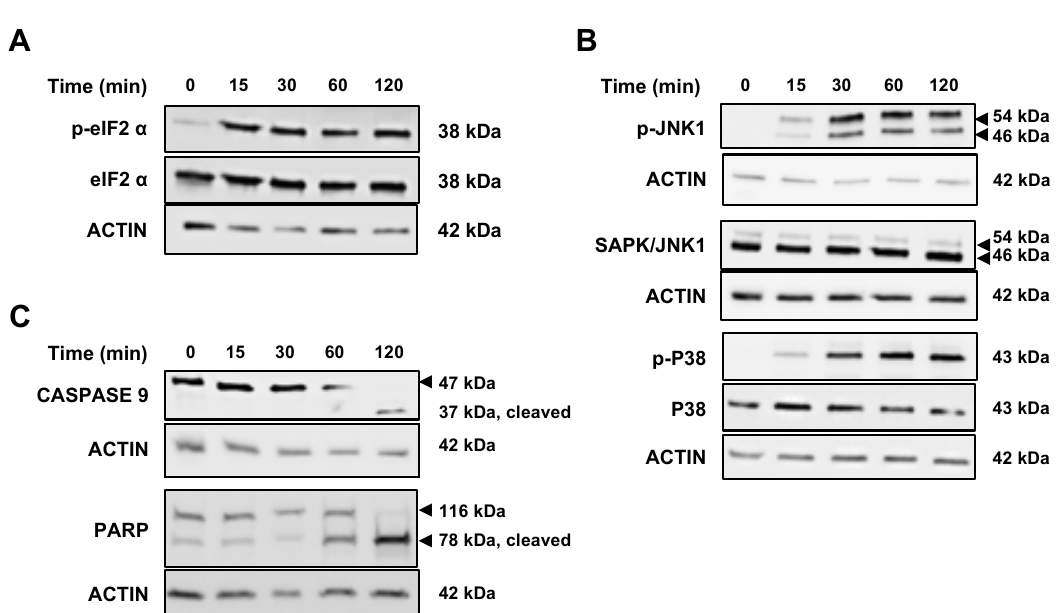
Figure 7. Effect of VAS3947 on unfolded protein response (UPR) proteins and apoptosis in MV-4-11 cell lines. ( A , B ) Western blot analysis showing the effect of VAS3947 (4 µM) on the expression of UPR proteins and their phosphorylation status at different indicated time points. ( A ) The activation of the PKR-like endoplasmic reticulum kinase (PERK) pathway is shown by the phosphorylation of eukaryotic initiation factor 2 alpha (eIF2α). ( B ) The activation of inositol-requiring enzyme 1α (IRE1α) is shown by the phosphorylation of c-Jun N-terminal protein kinase 1 (JNK1) and P38MAPK (mitogen-activated protein kinase). ( C ) Western blot analysis showing the activation of apoptosis through caspase 9 and PARP proteins’ cleavage at di ff erent indicated time points after VAS3947 (4 µ M) treatment. The β -actin was used as loading